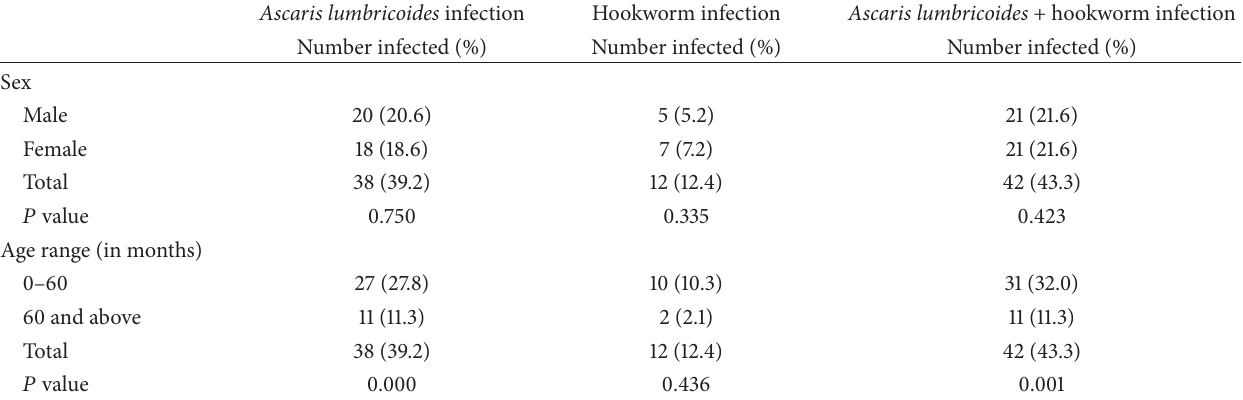
Table 3: Prevalence of geohelminth infection by sex and age group across the preschool aged children examined.